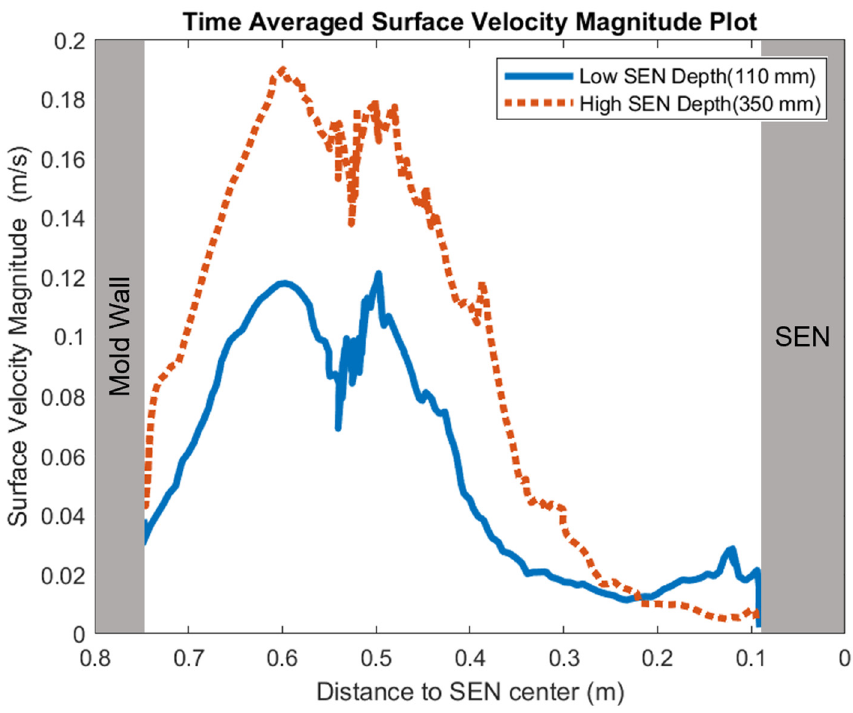
Figure 15. Low SEN depth (Case 4) vs. high SEN depth (Case 8) surface velocity comparison.